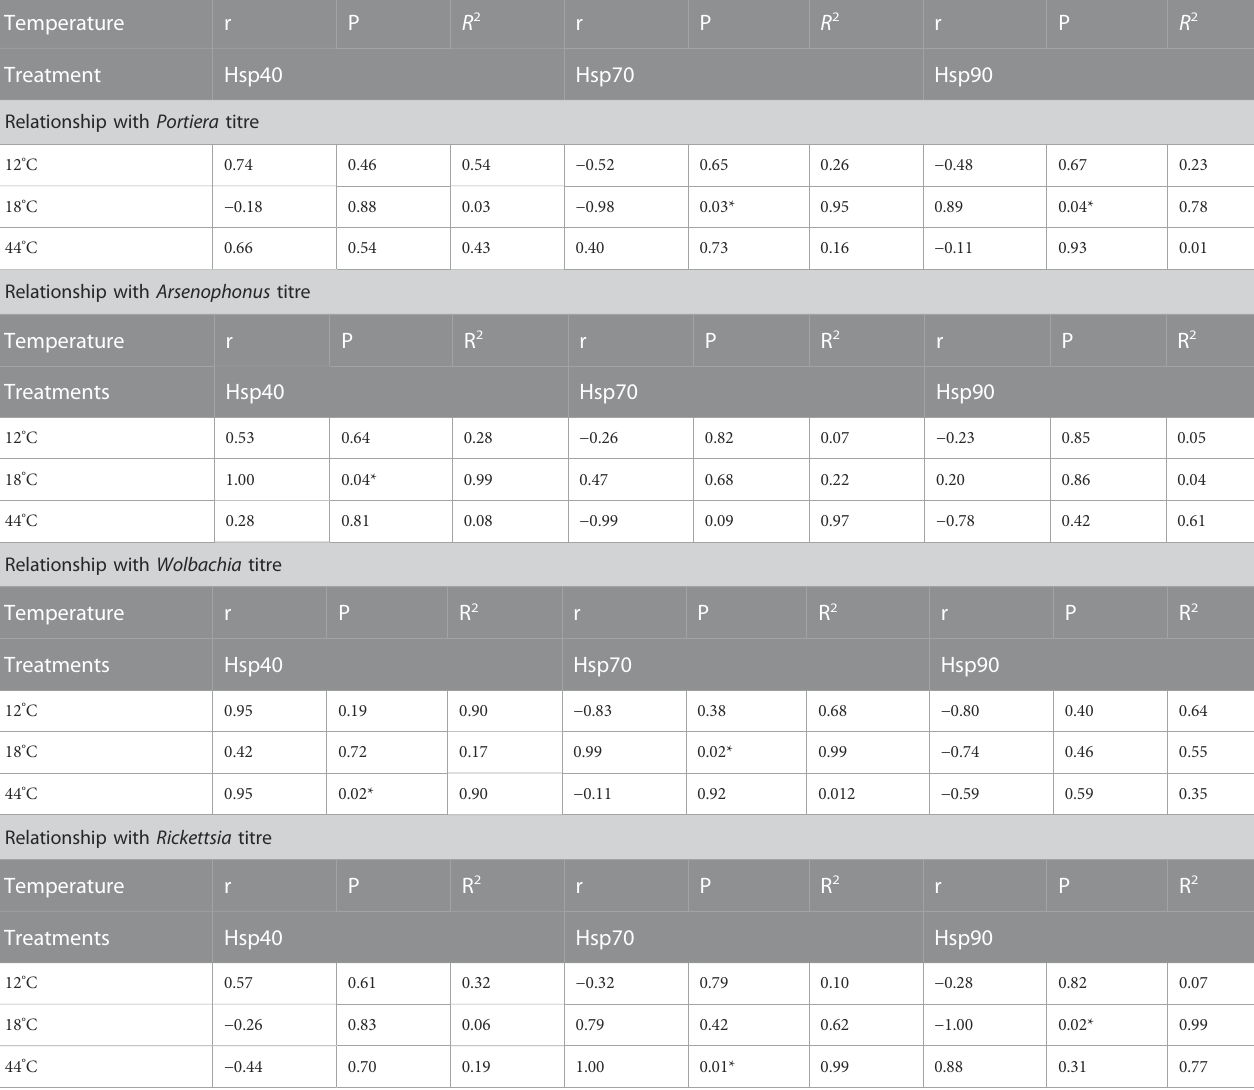
TABLE 2 Correlation of relative endosymbiont titres and Hsp gene expression, under different temperature treatments.